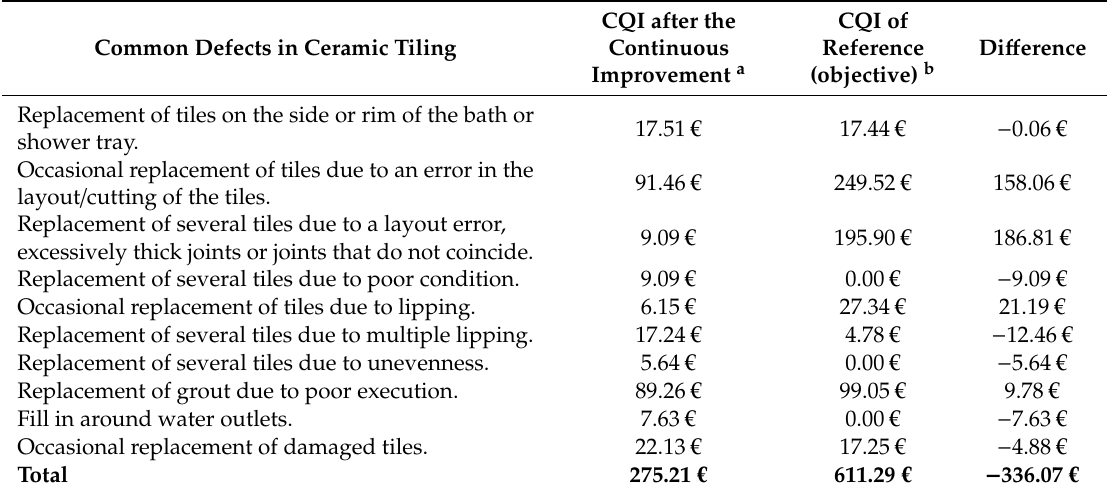
CQI after the CQI of Continuous Reference Di ff erence Improvement a (objective) b 17.51 € 17.44 € − 0.06 € 91.46 €